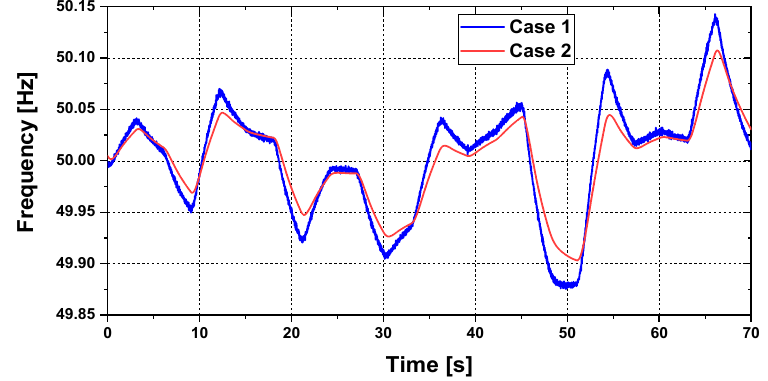
Electronics 2020 , 9 , 239